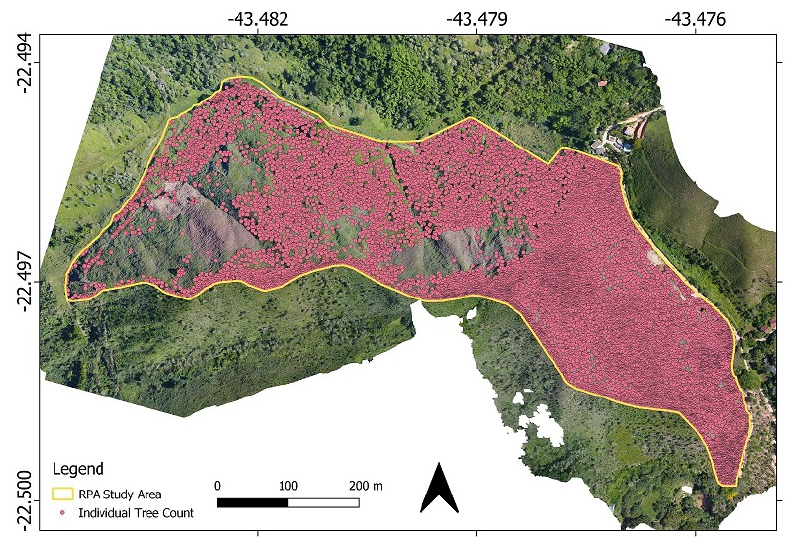
Figure 5. Individual Tree Count results of the RPA study area, which provided the Tree Density result when dividing all the identified trees by the area.